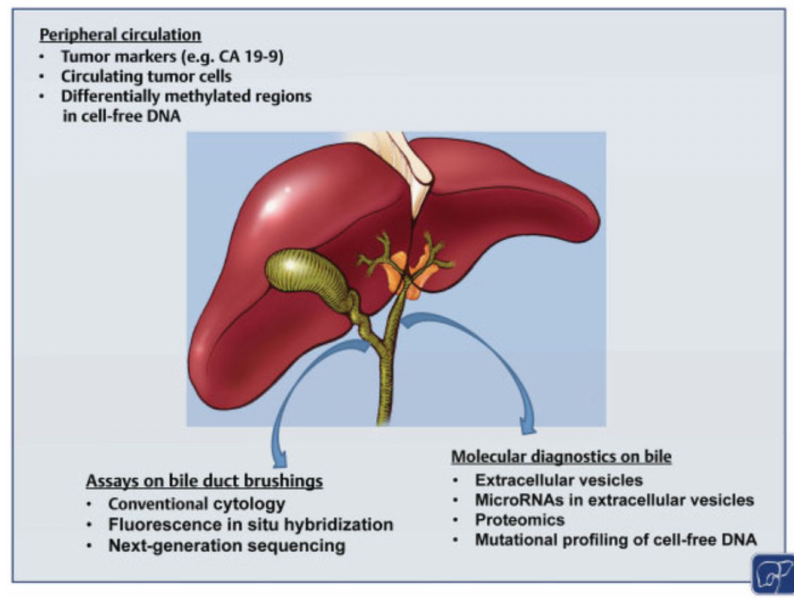
Figure 1. Biomarkers for perihilar cholangiocarcinoma